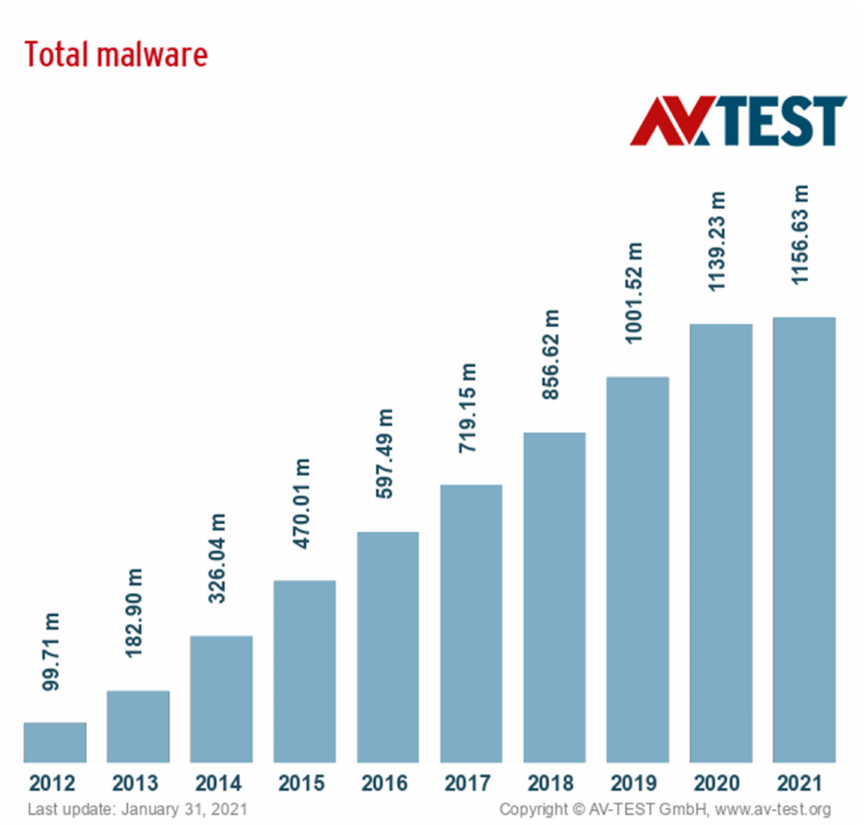
Figure 1. Overall development of new malware in the last 10 years, it can be seen that malwares is increasing prevalently. In 2021, there were more than 1.1 billion malicious codes as of the time this article was written. This figure is from av-test.org, accessed on 6 April